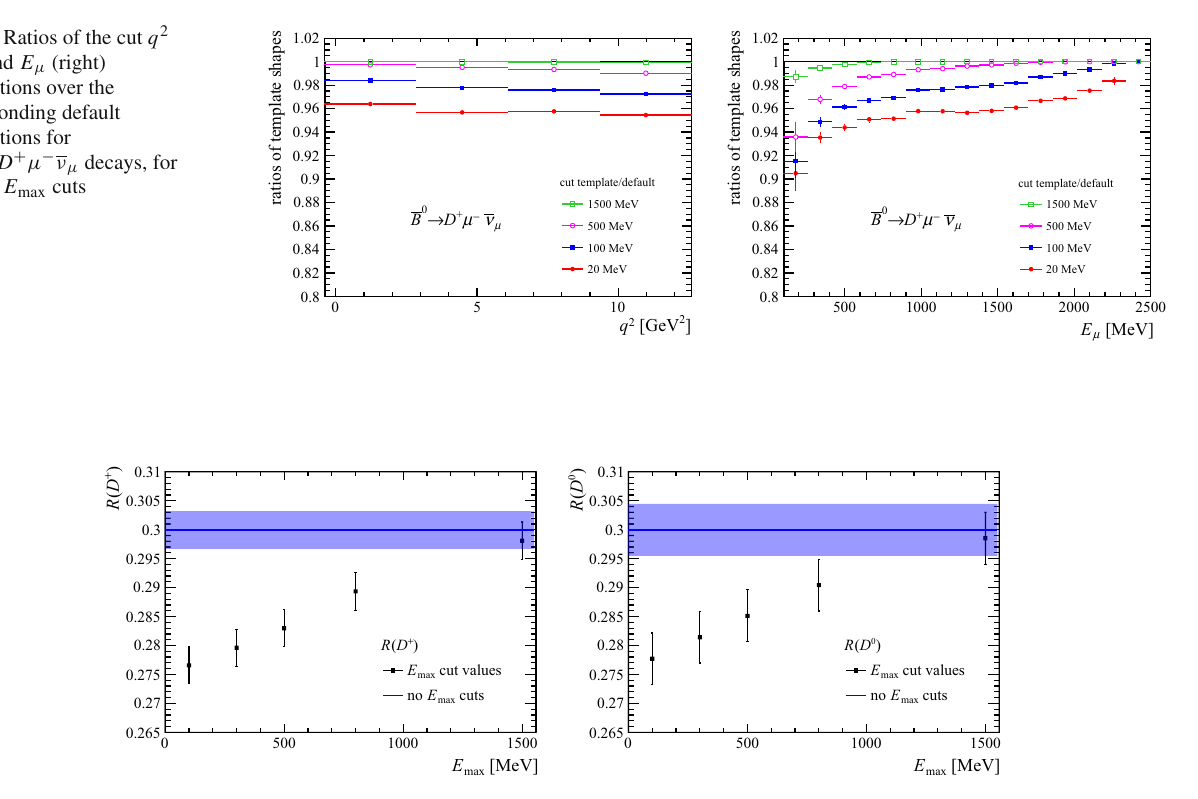
Fig. 9 Values of R ( D ) as a function of E max from a simplified LHCb- like analysis of R ( D + ) (left) and R ( D 0 ) (right). In this alternative approach, templates are generated according to Photos predictions and